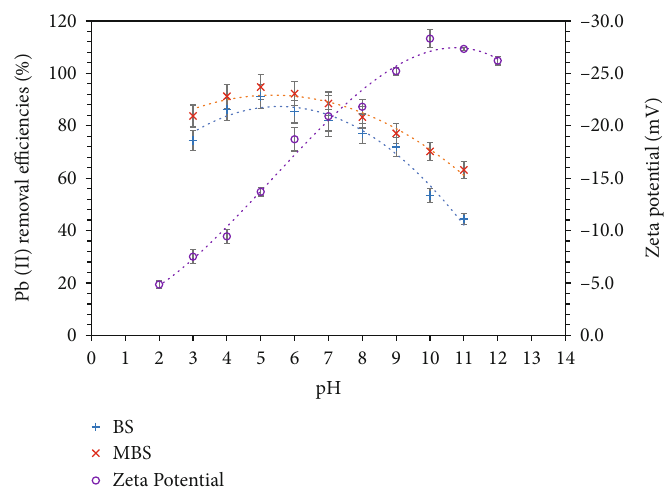
Figure 1: Zeta potentials and Pb (II) removal e ffi ciencies versus pH for BS and MBS. ± SD shown by error